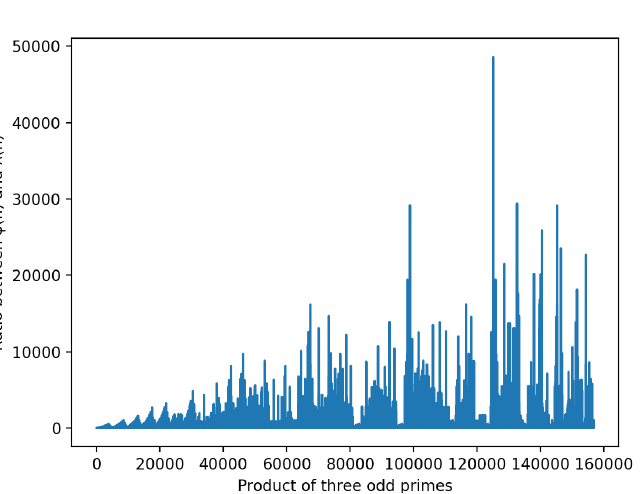
Figure 4. The Ratio between Carmichael and Euler functions for n less than